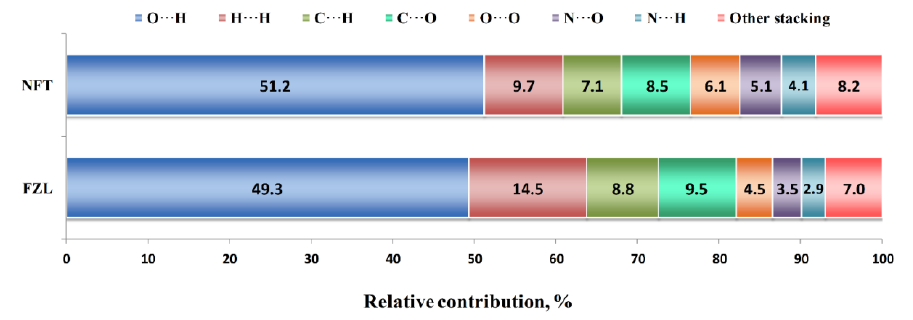
Figure 3. Results of the Hirshfeld surface analysis of NFT and FZL crystals.